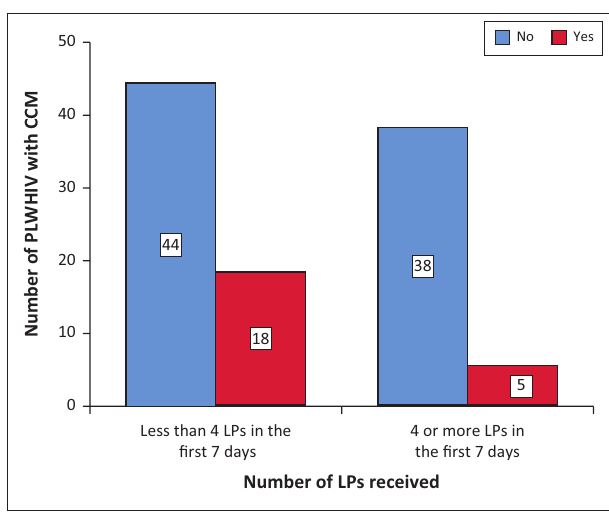
FIG URE 2: Clustered bar chart depicting in-hospital mortality and receipt of ≥ 4 lumbar punctures versus < 4 lumbar punctures in the first 7 days of combination antifungal therapy.